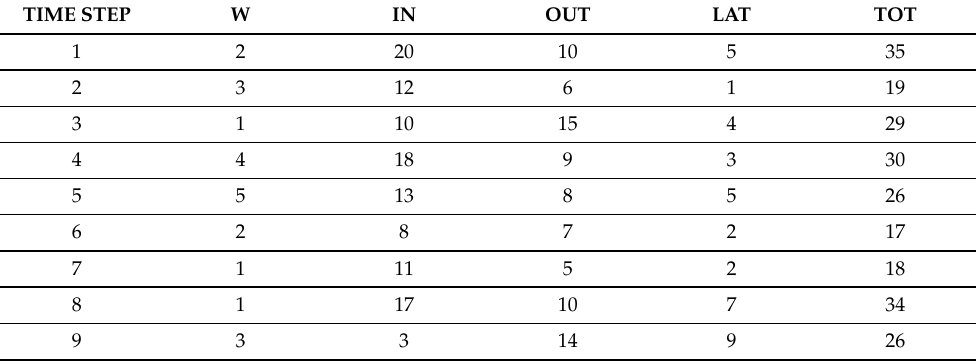
Table A1. Example dataset with nine records of W—weight, IN—incoming traffic, OUT—outgoing traffic, LAT—lateral traffic, and TOT—total traffic; TOT = IN + OUT +